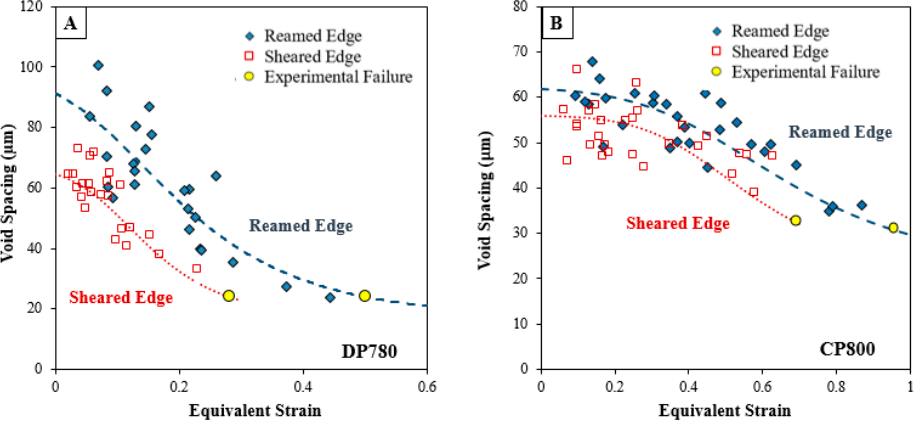
Figure 26. The evolution of void spacing ratio for the reamed and sheared edges of the ( A ) CP800 and ( B ) DP780 calculated analytically using Equation (8).